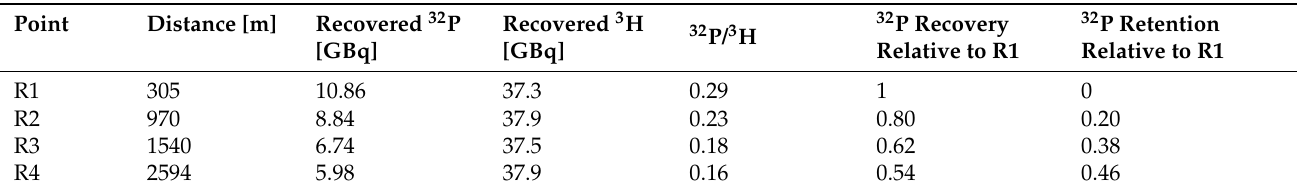
Table 2. Recovered tracer activities (corrected to the injection time) and 32 P retention at sampling points. Distance is measured from the injection point